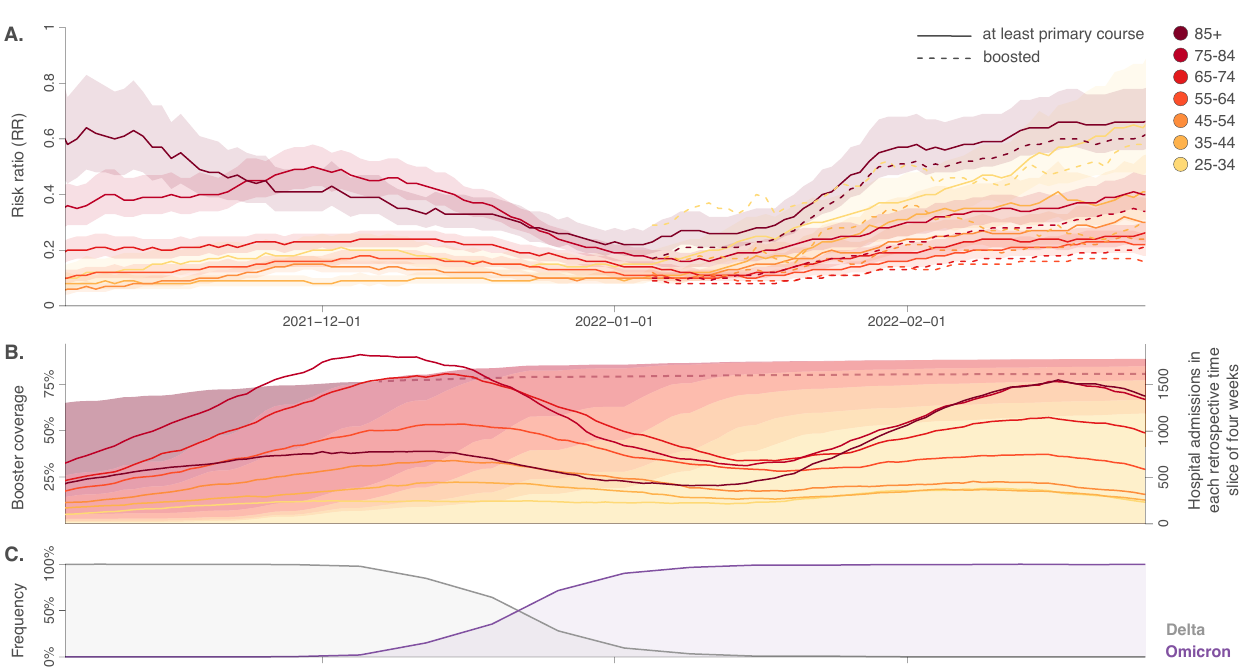
Figure 1. Approximation of vaccine impact on the risk of hospitalisation through the estimation of risk ratios (RR) between October 2021 and February 2022, based on the analyses of aggregated hospitalisation surveillance data collected in Belgium. ( A ) We here report RR values estimated for different age categories using a retrospective sliding window of four weeks. RR estimates are associated either with the “at least primary course completed” vaccination scheme (solid curves) or with the “boosted” vaccination scheme (dashed curves). Of note, in Belgium, hospitalised patients having had their booster jab were only registered as “boosted” at their admission from December 8, 2021. Therefore, we are only able to make the distinction between “primary course completed” and “boosted” vaccination schemes for the second half of the study period (15/12/22–28/02/22). Shaded polygons correspond to 95% confidence intervals associated with the “at least primary course completed” vaccination scheme (20). In addition, we also report ( B ) the progression of the Belgian booster vaccination campaign (shaded polygons *) and the evolution of the number of new hospitalisations in each slide of the retrospective sliding window of four weeks for the different age categories (curves), as well as ( C ) the temporal evolution of the relative detection frequency of the two main variants of concern (VOCs) circulating during that period in Belgium. (*) Because hidden on the graph by the progression of the booster vaccination campaign for younger age categories, the related progression for the 85+ is highlighted by a dashed curve from early